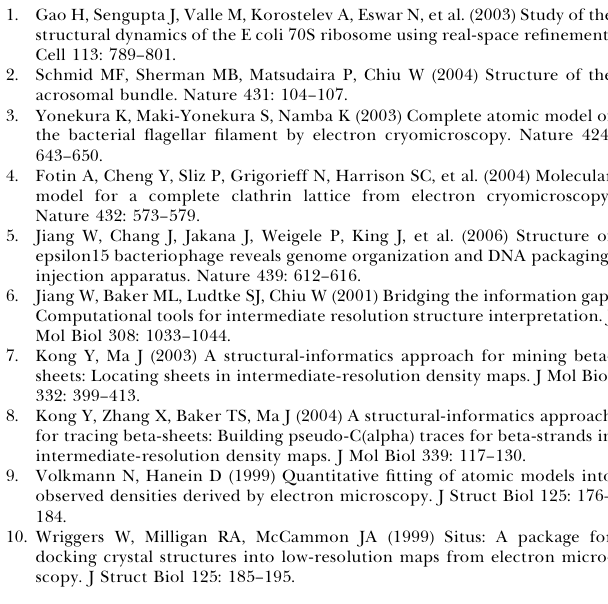
Figure S2. Plot of the Two-Way Similarity Score for the VP26 Core Domain Decoys